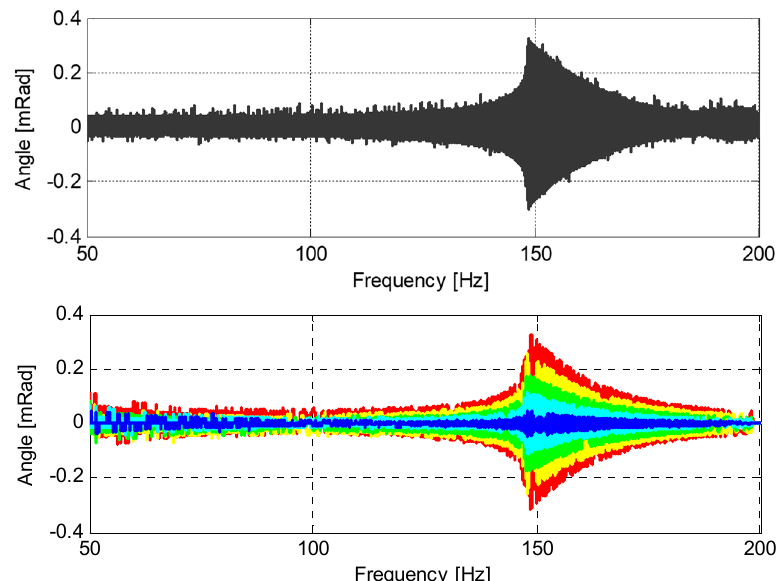
Figure 13. The results of RC testing. Standard RC test results are at the top; the results from the additional accelerometers are at the bottom. Material: Sand 3 (Sa); Isotropic pressure 50 kPa; Frequency spectrum 50–200 Hz; Excitation (torque) amplitude 0.5 V (– original built-in sensor, – the top sensor, S1, – the second sensor from the top, S2, – the third sensor from the top, S3, – the fourth sensor from the top, S4, – the bottom sensor, S5).